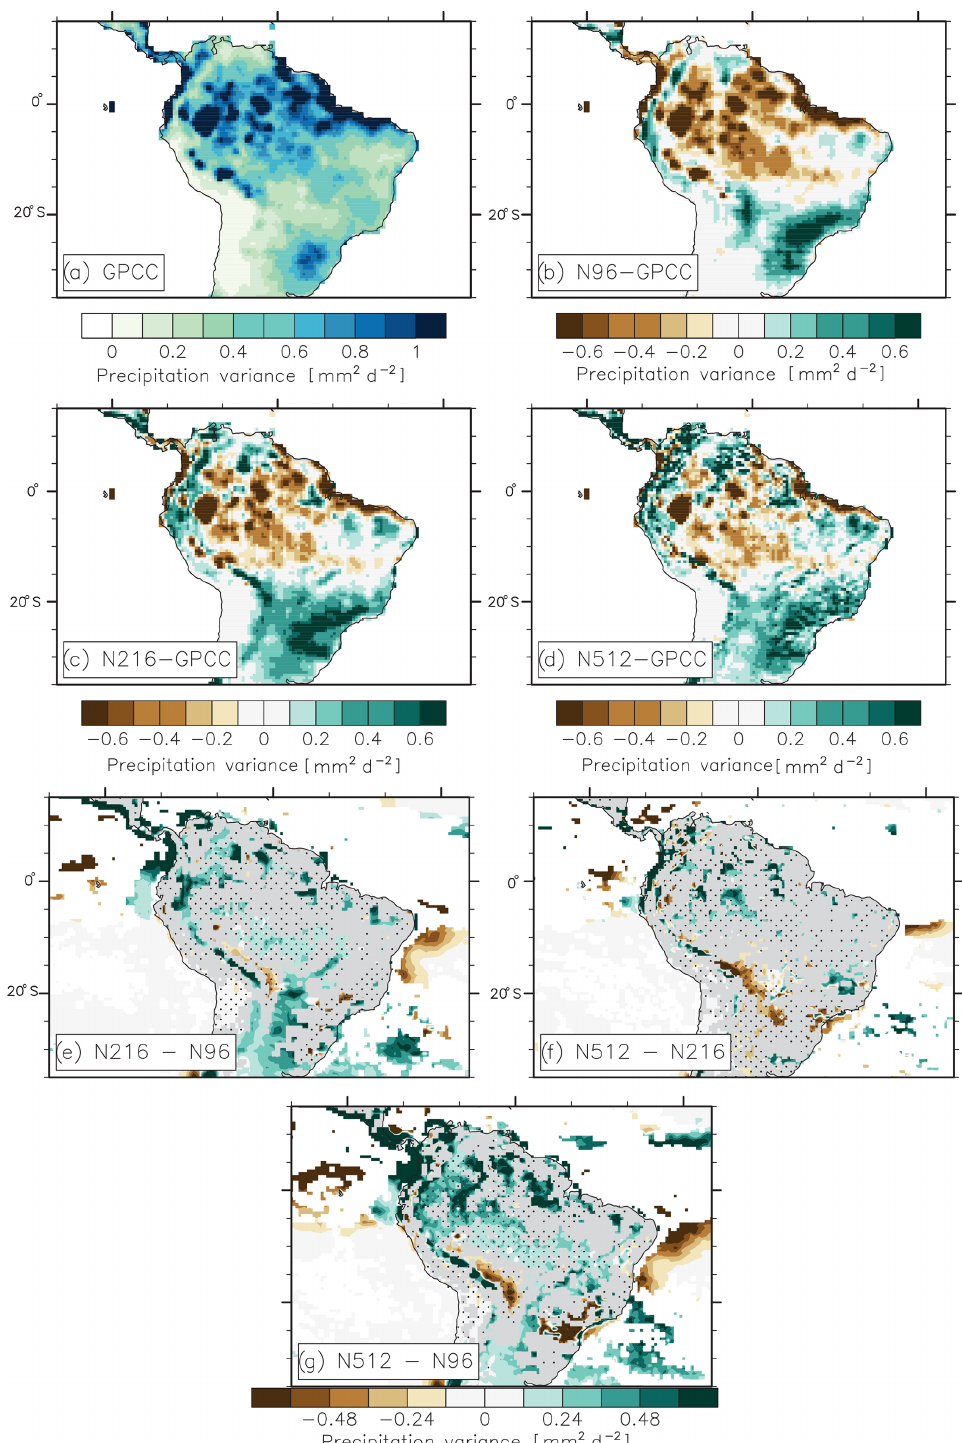
Figure 4. (a) Observed annual-mean precipitation variance (GPCC; mm 2 d − 2 ), as computed over the period 1982–2014. A linear trend is removed. Bias in annual-mean precipitation variance in (b) N96 (i.e. N96–GPCC), (c) N216 (i.e. N216–GPCC), and (d) N512 (i.e. N512– GPCC). (e) N216–N96, (f) N512–N216, and (g) N512–N96 differences in annual-mean precipitation variance. In (b) , (c) , and (d) , biases are shown when all three members produce a bias that is significant according to an f test and a 95% confidence level. In (e) , (f) , and (g) , stippling indicates that the bias is improved at the higher rather than at the lower